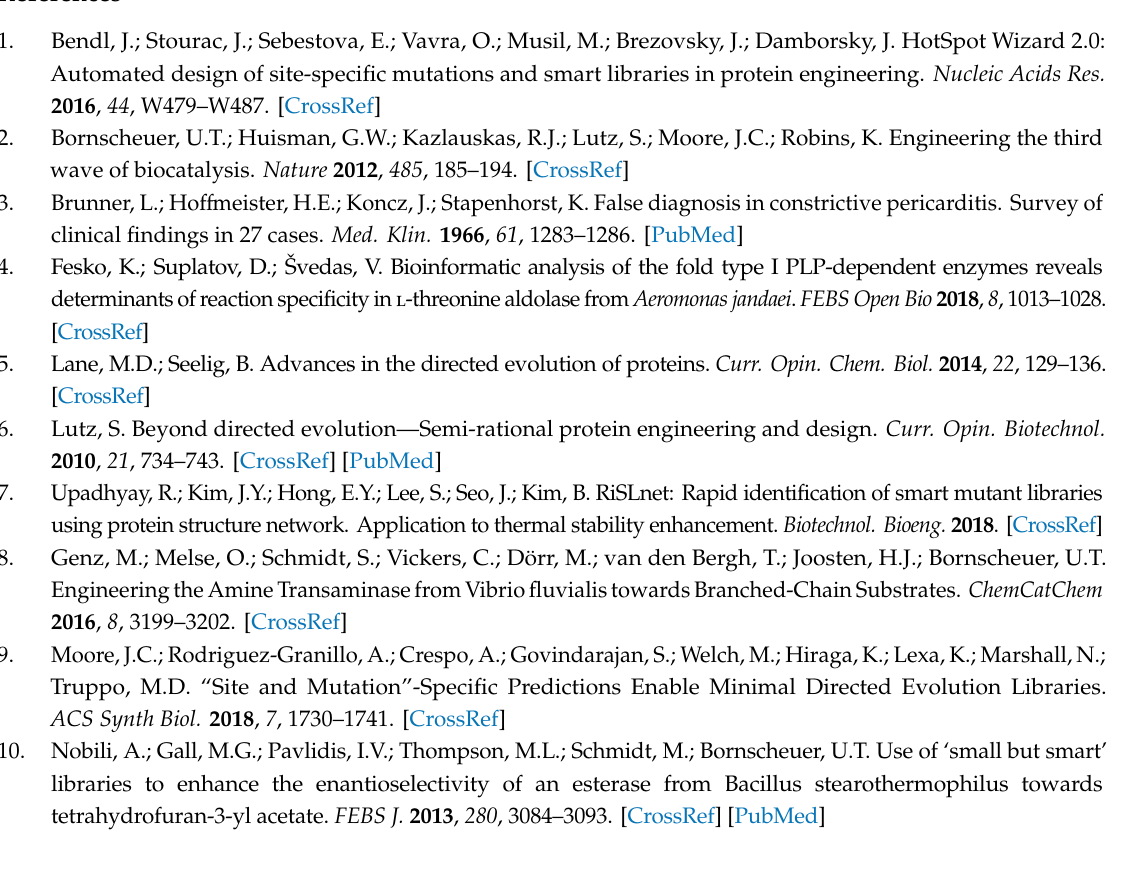
Table S1: Crystallography data—collection statistics, Table S2: Crystallography data—refinement statistics, Table S3: Mn2 + ligands and coordination distances (Å), Table S4: Average time required for the exchange of water molecules between the main cavity and bulks solvent for the wild-type and four mutant structures, Figure S1: Invariance of EPR spectra from the PfPGI